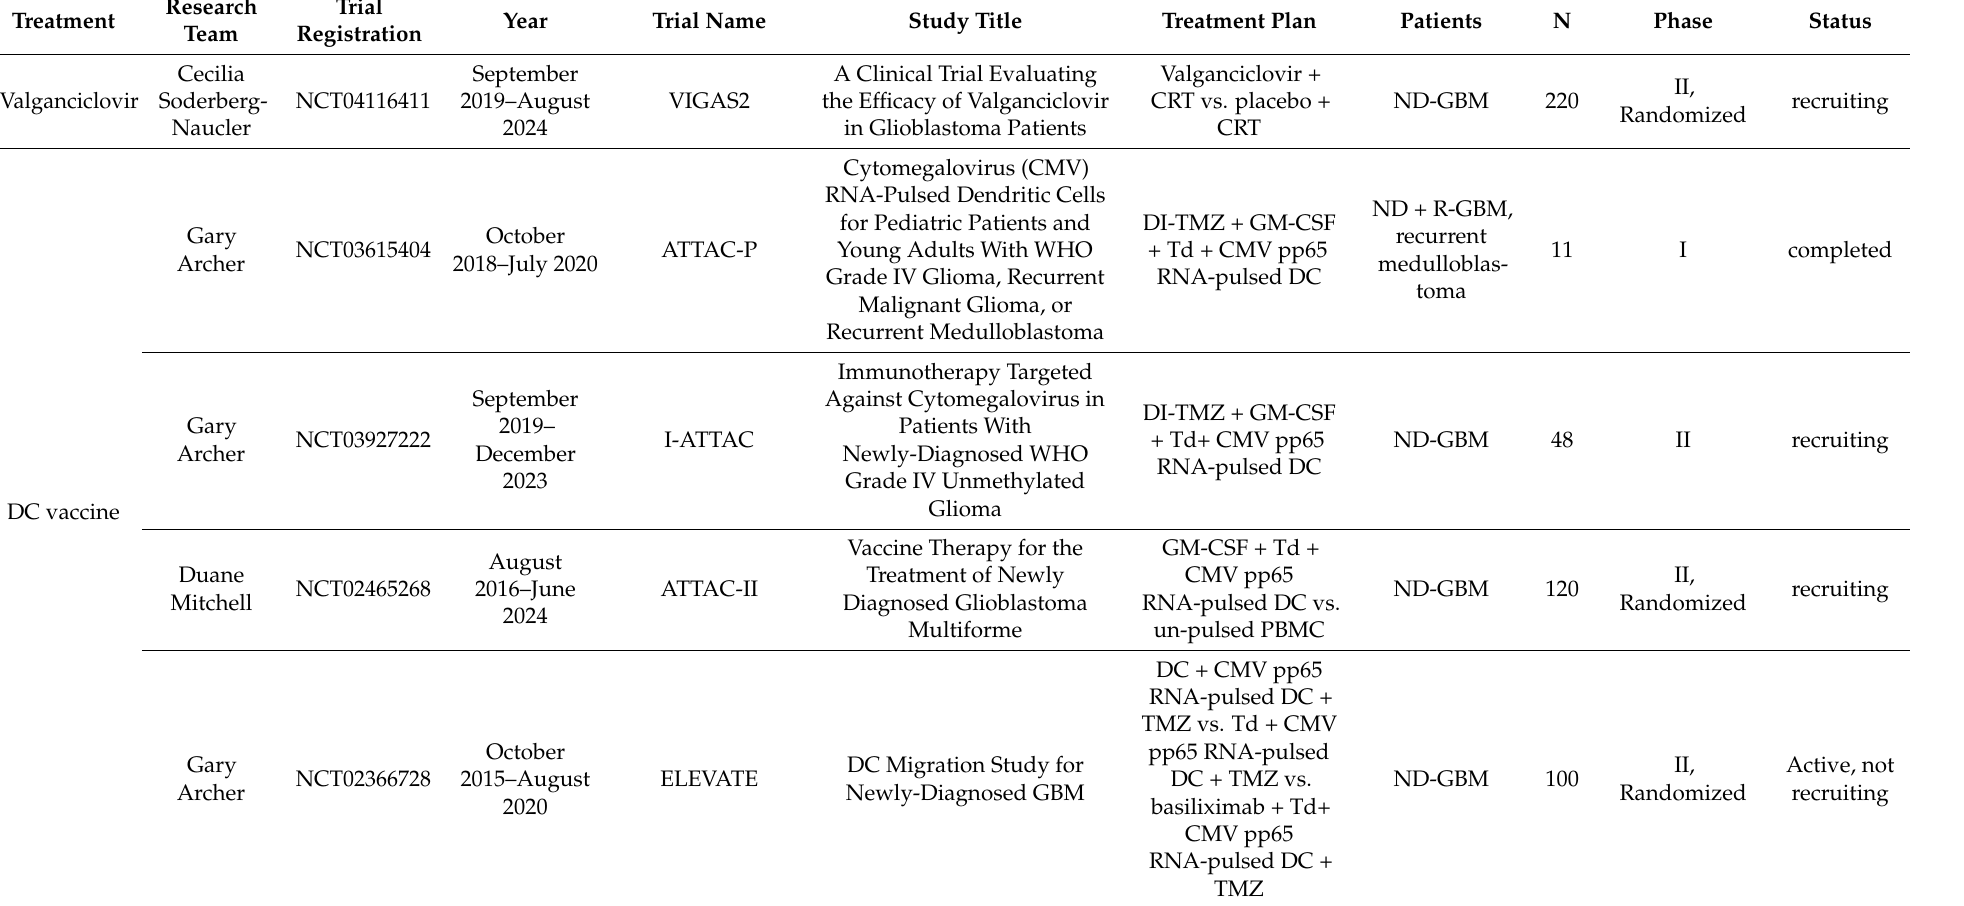
Table 2. Ongoing clinical trials of anti-CMV treatment in